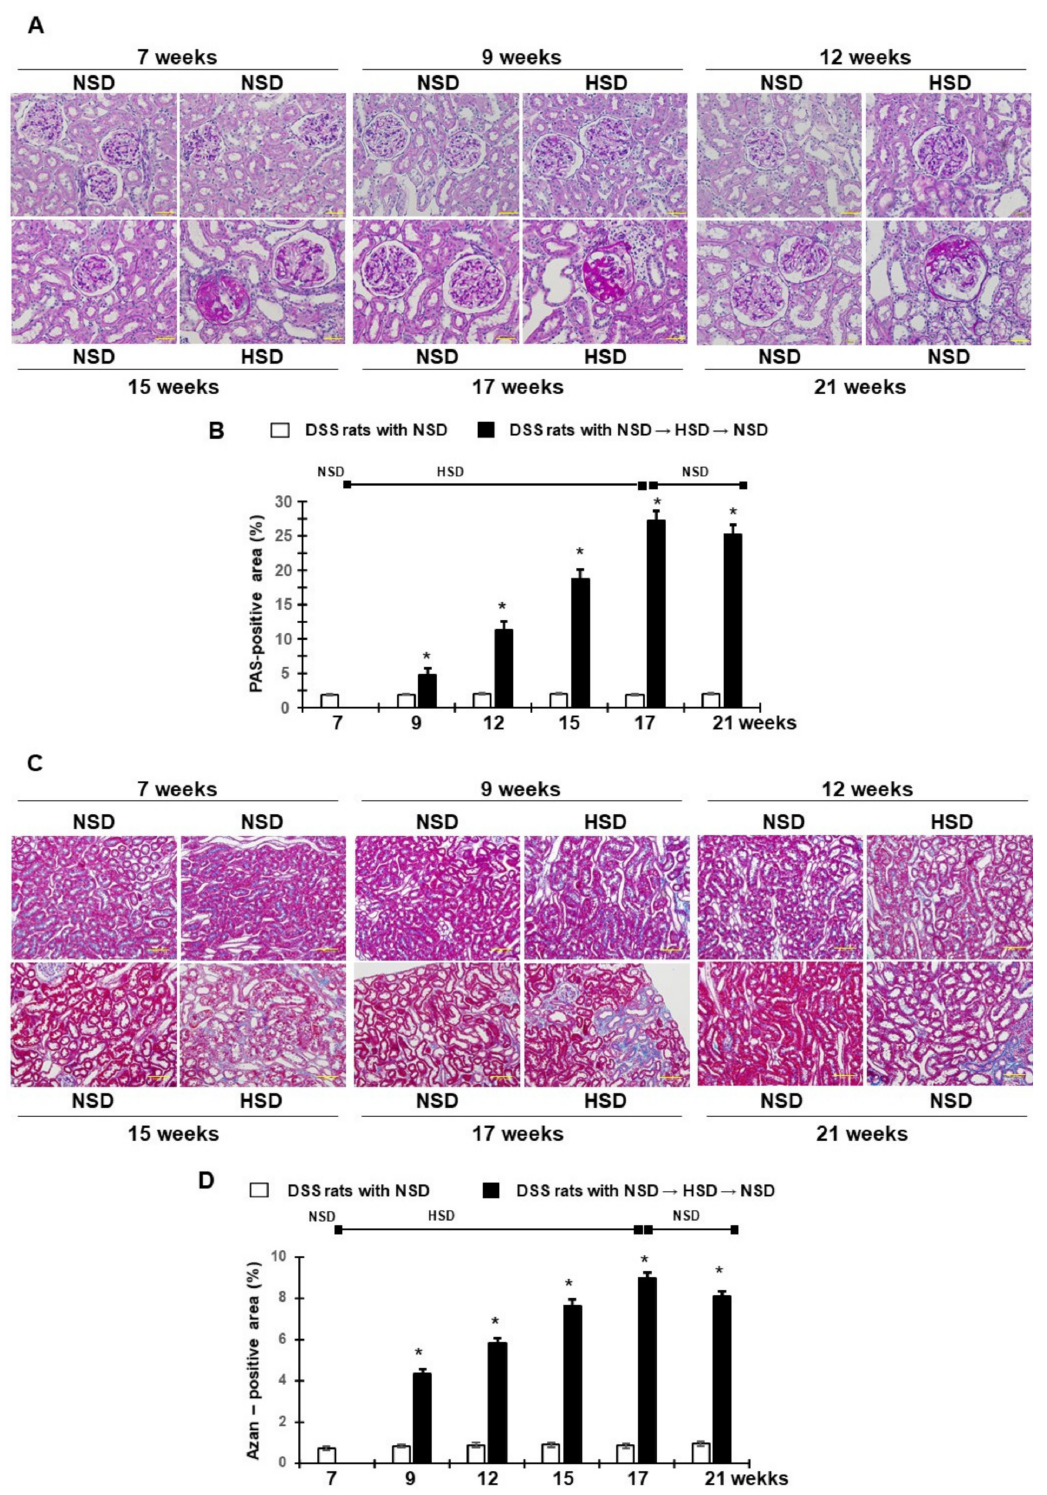
Figure 6. E ff ects of HSD on renal glomerular and tubulointerstitial injury. ( A ) Representative’s images of PAS-stained renal sections (magnification, × 200; scale bar 50 µ m). ( B ) The PAS-positive area within the glomerular area. ( C ) Representative micrographs of Azan-stained renal sections (magnification, × 100, scale bar 100 µ m). ( D ) Quantitative analysis of Azan-positive area. * p < 0.05 vs. DSS rats with